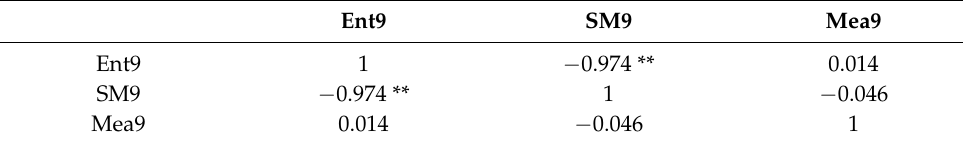
Table 11. Correlation coefficient matrix of texture features in short-wave infrared band